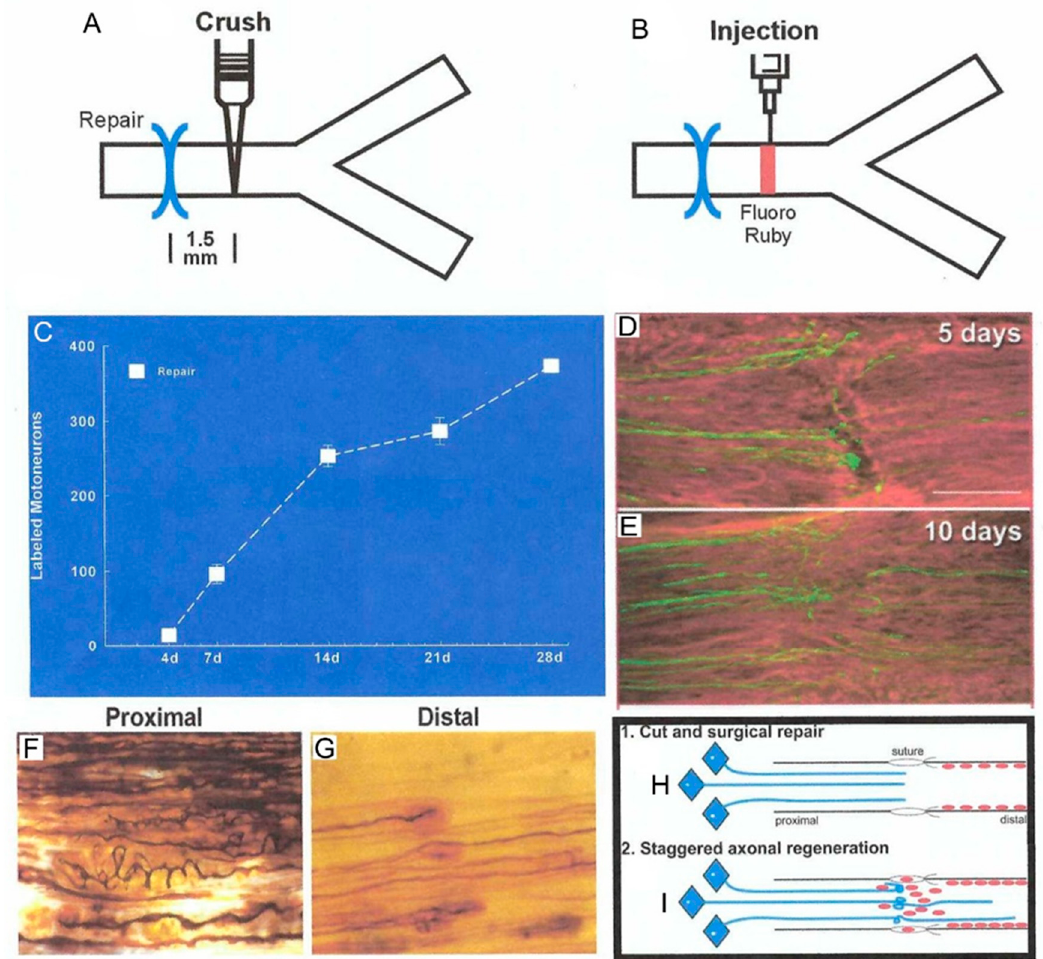
a progressive decline to baseline values in the upregulation of the mRNA of the cytoskeletal protein tubulin in axotomized motoneurons ( E ). Semi-quantitation of the gene expression of Glial derived quantitation of the gene expression of Glial derived neurotrophic factor (GDNF) in the denervated neurotrophic factor (GDNF) in the denervated distal nerve stump with rt-PCR, showing an exponential distal nerve stump with rt-PCR, showing an exponential decline ( F ). The parallel expression of p75 decline ( F ). The parallel expression of p75 and infiltration of macrophages into the denervated distal and infiltration of macrophages into the denervated distal nerve stump ( G ). The slow rate of nerve stump ( G ). The slow rate of Wallerian degeneration of the isolated nerve in the denervated distal Wallerian degeneration of the isolated nerve in the denervated distal nerve stump is illustrated in the nerve stump is illustrated in the longitudinal micrographs of the denervated distal nerve stump ( H – J ) longitudinal micrographs of the denervated distal nerve stump ( H – J ) leaving parallel endothelial leaving parallel endothelial tubes with immunologically stained p75 expressing SCs by 12 weeks ( K ) tubes with immunologically stained p75 expressing SCs by 12 weeks ( K ) that declines within 6- that declines within 6-months ( L , M ). Adapted from [19]. months ( L , M ). Adapted from [19].